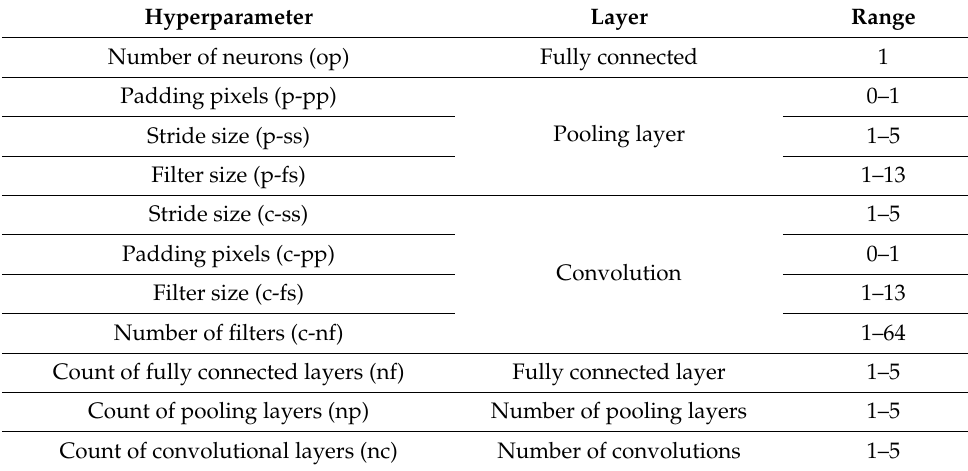
Table 2. Implementation variables.